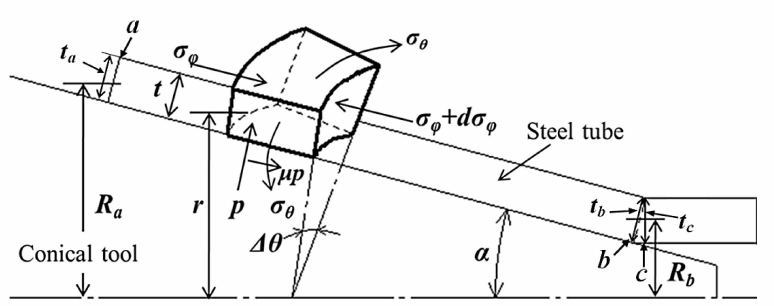
Figure 10. Mechanical equilibrium diagram of the deformation part of tube end during the expansion stage of the flaring